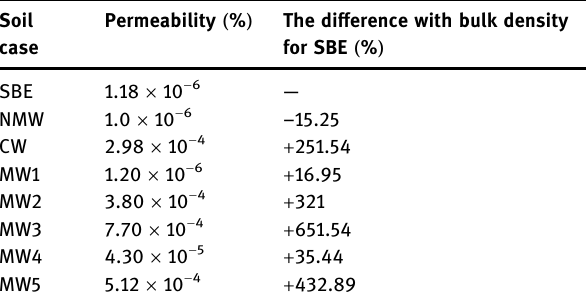
Table 6: The percentage of increase and decrease in the amount of permeability of the soil